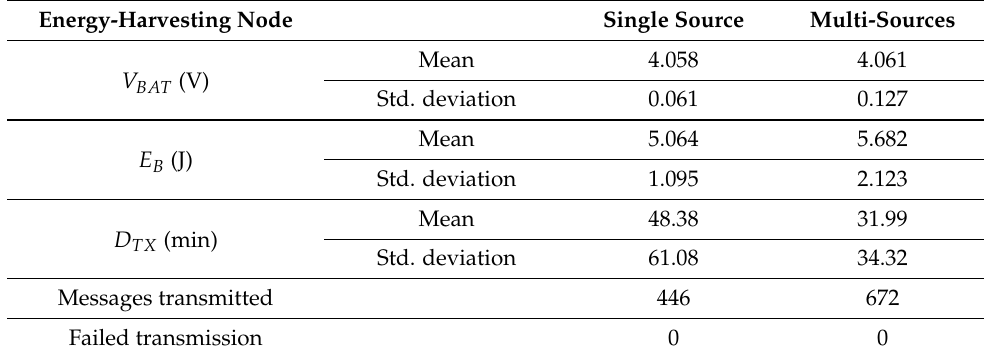
Table 5. Performance of single- and multi-source energy-harvesting systems.